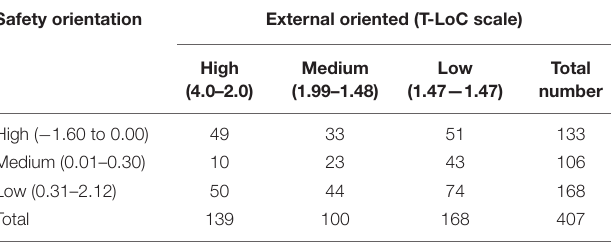
Data in parentheses represent the mean inclusion values for each ratings